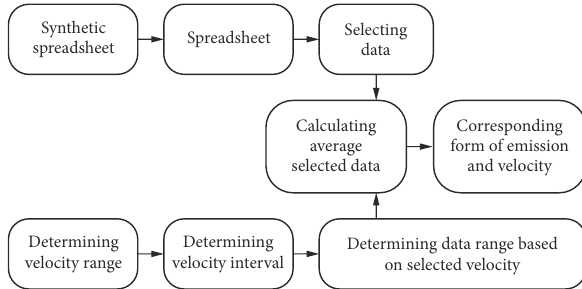
Figure 8. Processing procedure for selecting modelling data